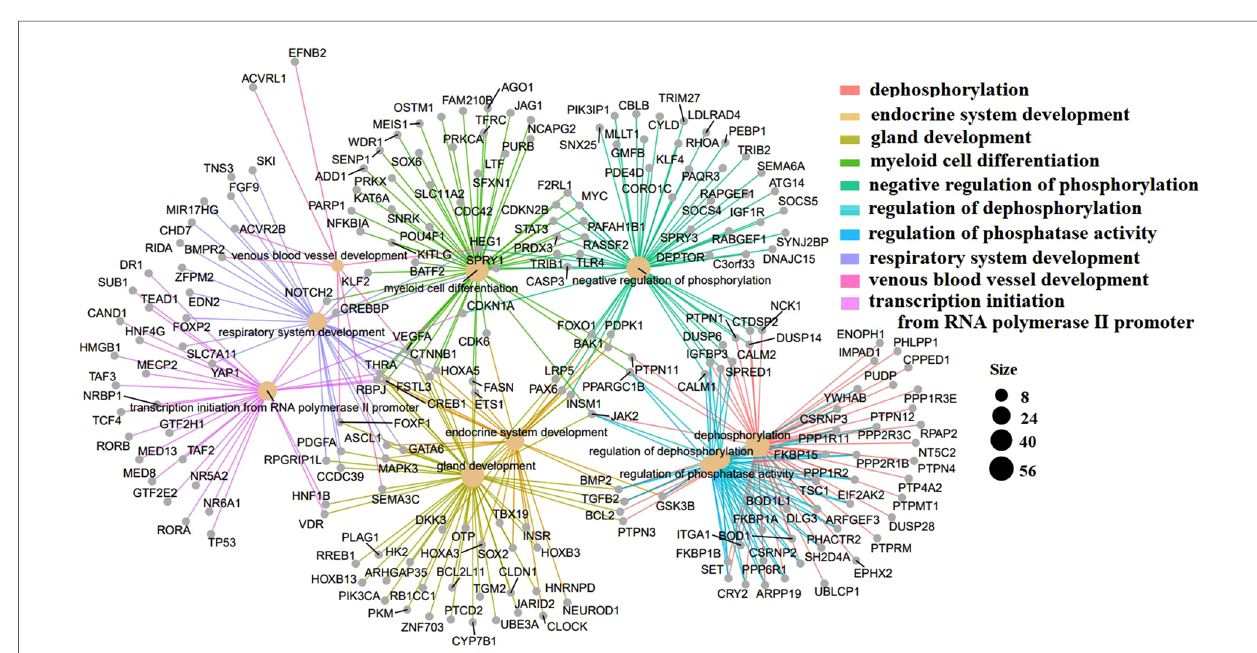
FIGURE 5 Top 10 GO terms with the lowest p -values. Biological pathways and associated genes were identi fi ed. Each node indicates a biological process in the path. The lines are the interactions between the genes and the